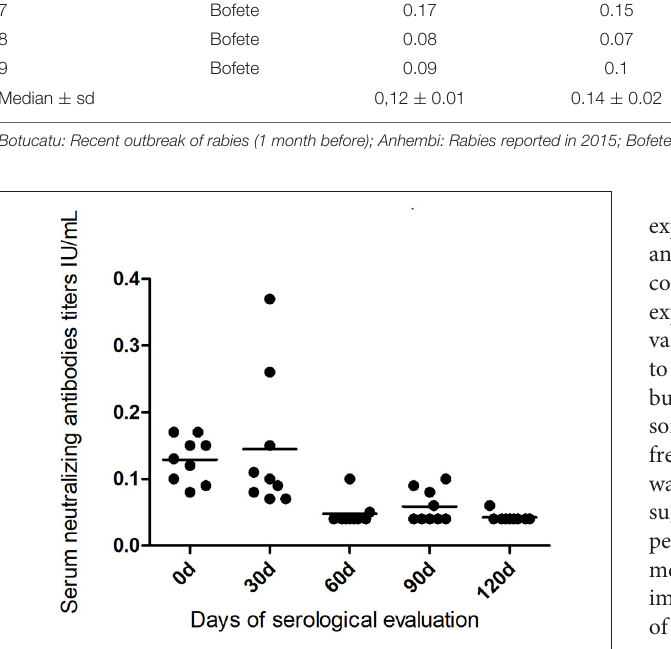
The high proportion of antibodies considered as protective for rabies among bats sampled in Botucatu suggests the presence and circulation of the virus (8, 11) and corroborates cases reported among livestock in nearby farms. Although the second collection of bats 30 days later was much smaller ( N = 5), there was a decrease on the proportion of seropositive animals. This decrease suggests that not all bats in a colony are exposed to the virus and outbreak